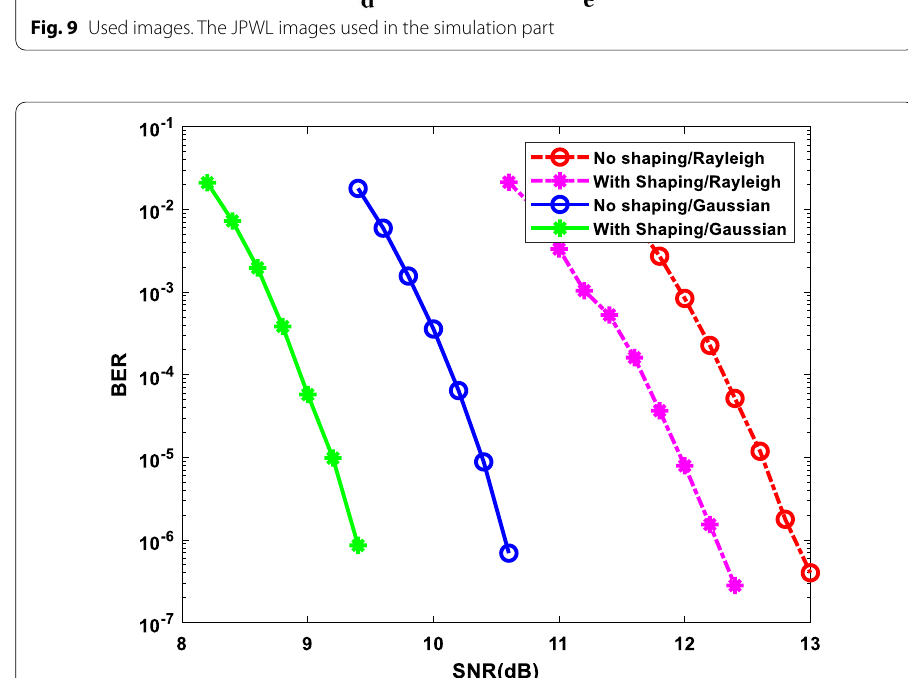
Fig. 10 BER performance of the SISO BICM system through Gaussian and Rayleigh channels. BER performance for the SISO BICM system with and without shaping code, at a spectral efficiency of 4 bits/s/Hz over Gaussian and Rayleigh